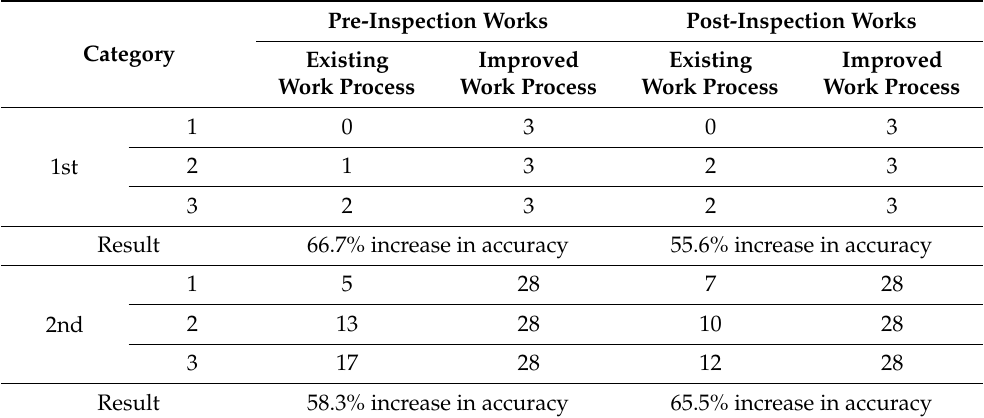
Table 6. Work accuracy measurement results from each work process. Pre-Inspection Works Post-Inspection Category